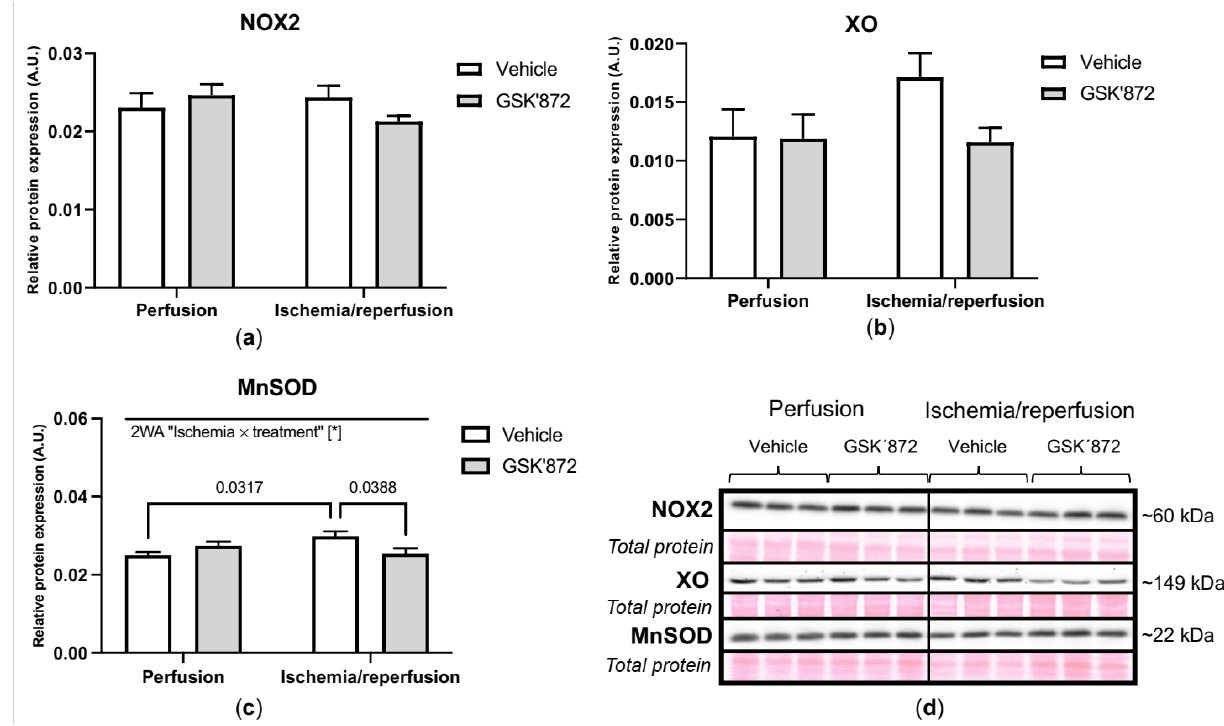
Figure 6. Analysis of oxidative stress in left ventricles lysates; immunoblot quantification of NOX2 ( a ), XO ( b ), MnSOD ( c ); representative immunoblots and total protein staining ( d ). Data are presented as mean ± SEM; * p < 0.05. 2WA—two-way ANOVA; “Ischemia × treatment”—interaction of the presence of ischemia/reperfusion and